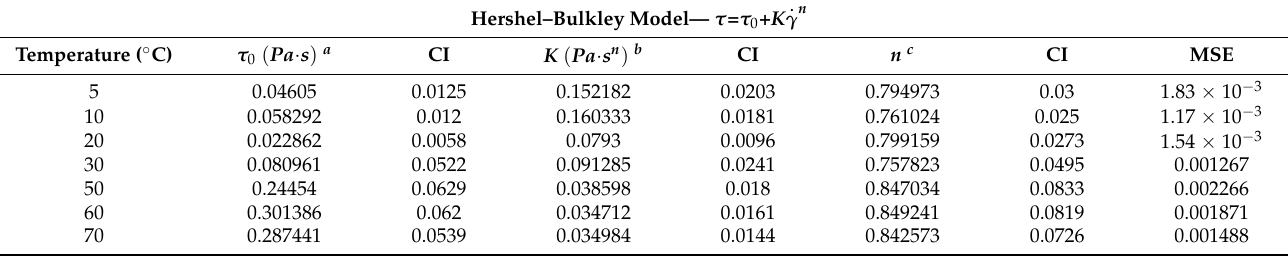
Table A5. Fitting parameters ( τ 0 , K , n ), confidence intervals (CI), and mean square error (MSE) values as a function of temperature obtained from the Hershel–Bulkley model [48], modeling the 0.1 to 1000 s − 1 shear rate range for flow curve data sets of ink suspensions with a 0.40 wt% HRCM load. Hershel–Bulkley Model— τ = τ 0 + K . γ n